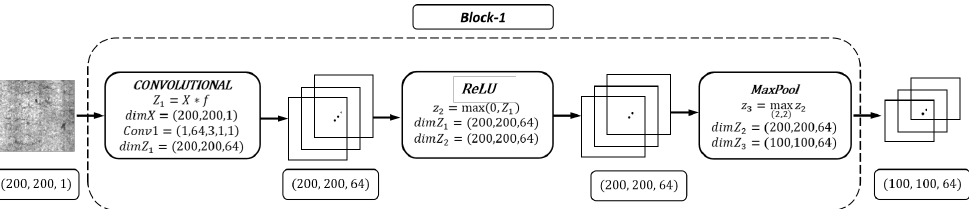
Figure 1. ConCNN architecture.